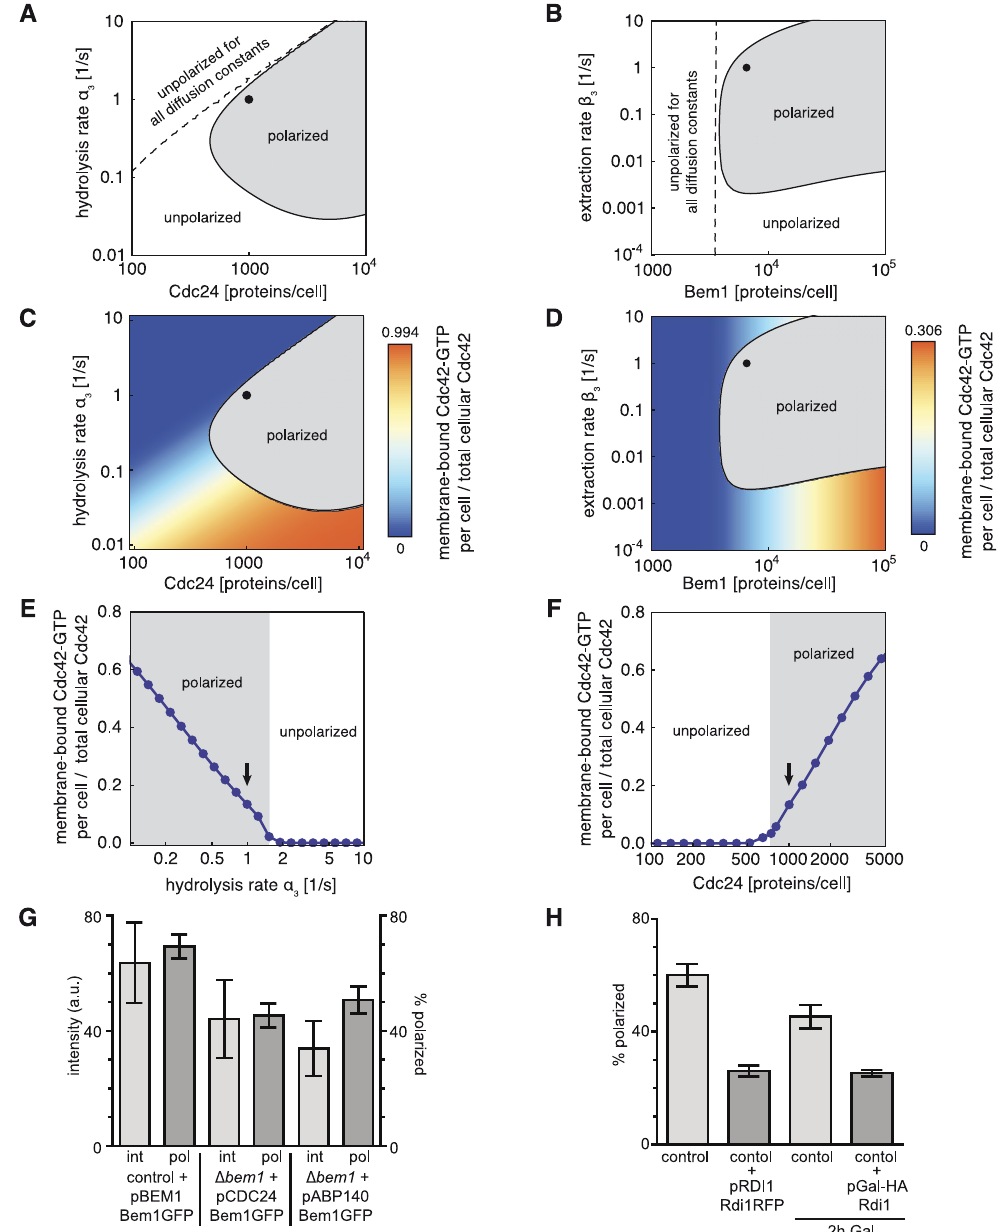
Figure 4. Parameters affecting polarization efficiency and Cdc42 activation. A,B Polarization capability predicted from the linear stability analysis shown for different concentrations of the GEF Cdc24 and Cdc42 hydrolysis rates (A) as well as for different concentrations of Bem1 protein and Cdc42 extraction rates (B). In addition, parameter regions are shown where polarization cannot be rescued by a change of the diffusion constants D 2 , D 3 . Black dots indicate values in control cells. C,D Plots as in (A, B) but in addition indicating concentration of membrane-bound Cdc42-GTP (as fraction of total cellular Cdc42) in unpolarized cells. Black dots indicate values in control cells. E,F Concentration of membrane-bound Cdc42-GTP for different Cdc42 hydrolysis rates (E) and Cdc24 protein numbers per cell (F). The arrows indicate the control cell values. G Comparison of average intensity and polarization efficiency of latrunculin B-treated control and D bem1 cells expressing Bem1-GFP from the endogenous or the weak Cdc24 or Abp140 promoter. ANOVA, F(2,6)=25.52: P=0.0012, Dunnett’s posthoc: control-p24: p , 0.001, control-pAbp140: p , 0.01. H Polarization efficiency of GFP-Cdc42 control cells treated with latrunculin B without or with the overexpression of Rdi1. Rdi1 was either overexpressed as an additional copy under its endogenous promoter or under the Gal-promoter. Unpaired t-test with Welch correction: control - pRDI1-Rdi1RFP: p , 0.001, control - pGal-Rdi1: